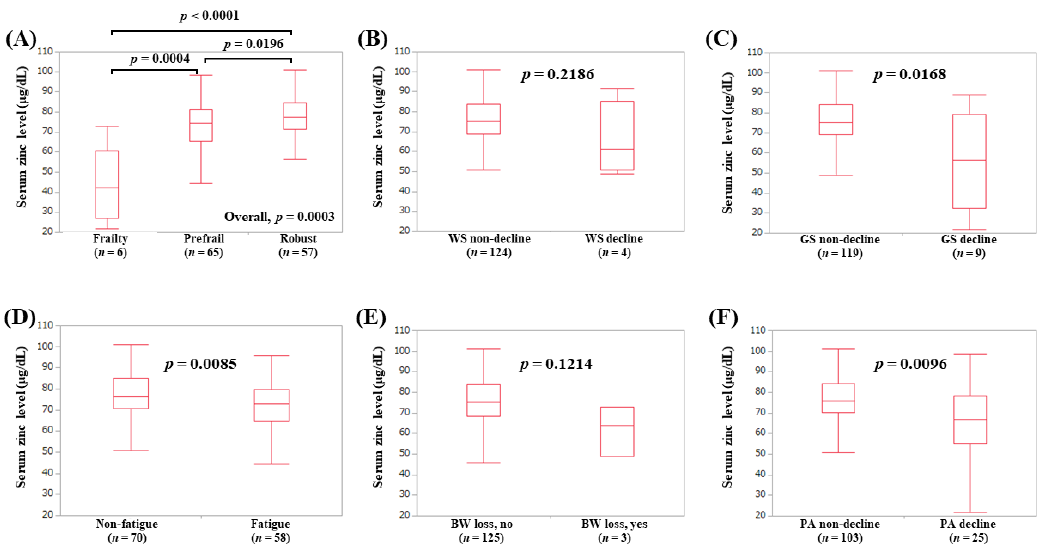
Figure 7. Serum Zn level according to the frailty status ( A ) and serum Zn level according to each frailty phenotype in patients less than 65 years: ( B ) walking speed, ( C ) grip strength, ( D ) fatigue, ( E ) body weight loss, ( F ) physical activity.